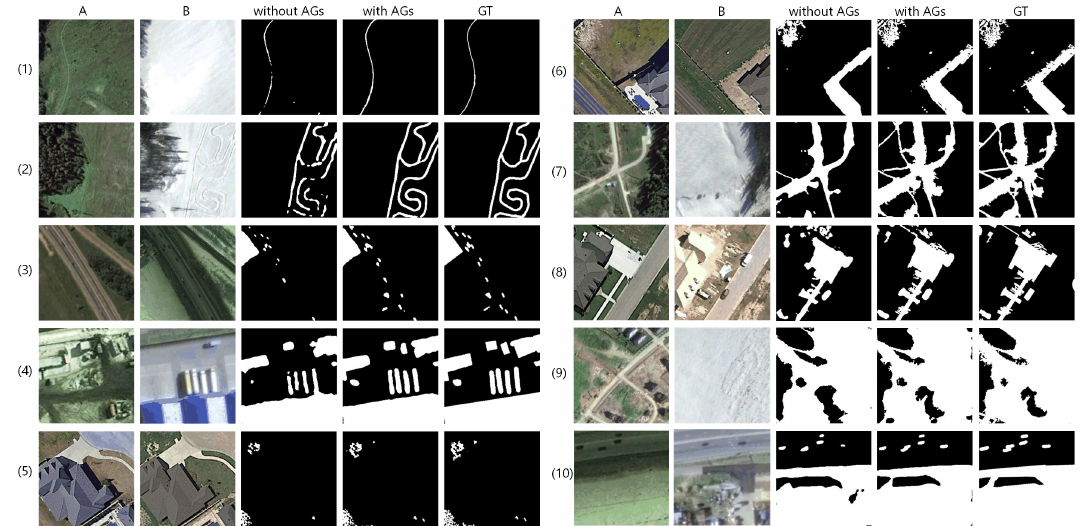
Figure 6. Qualitative comparison of applying AGs under coarse detection and coarse-to-fine